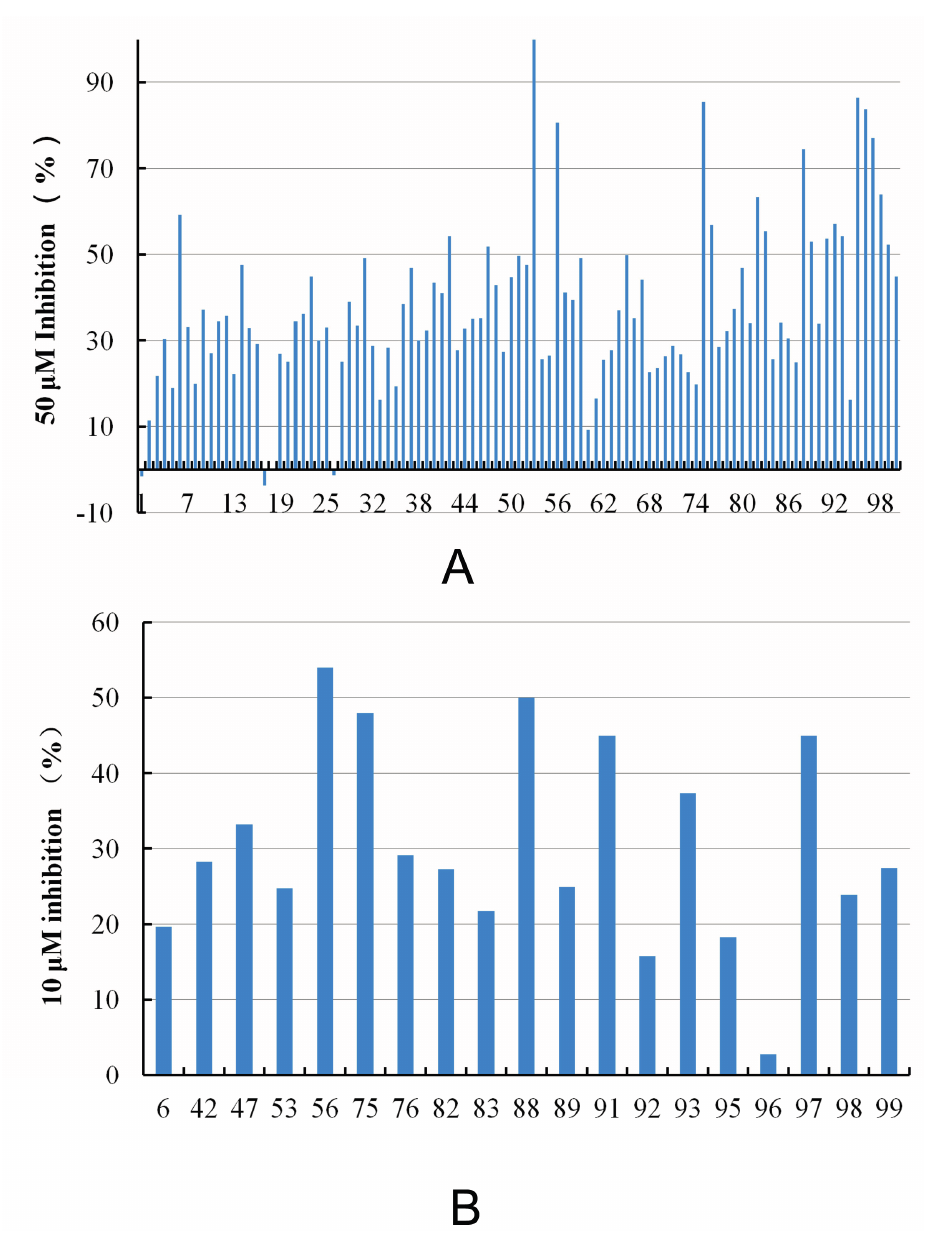
Figure 6. Inhibition ratio of FGFR1 at ( A ) 50 μ M and ( B ) 10 μ M compound